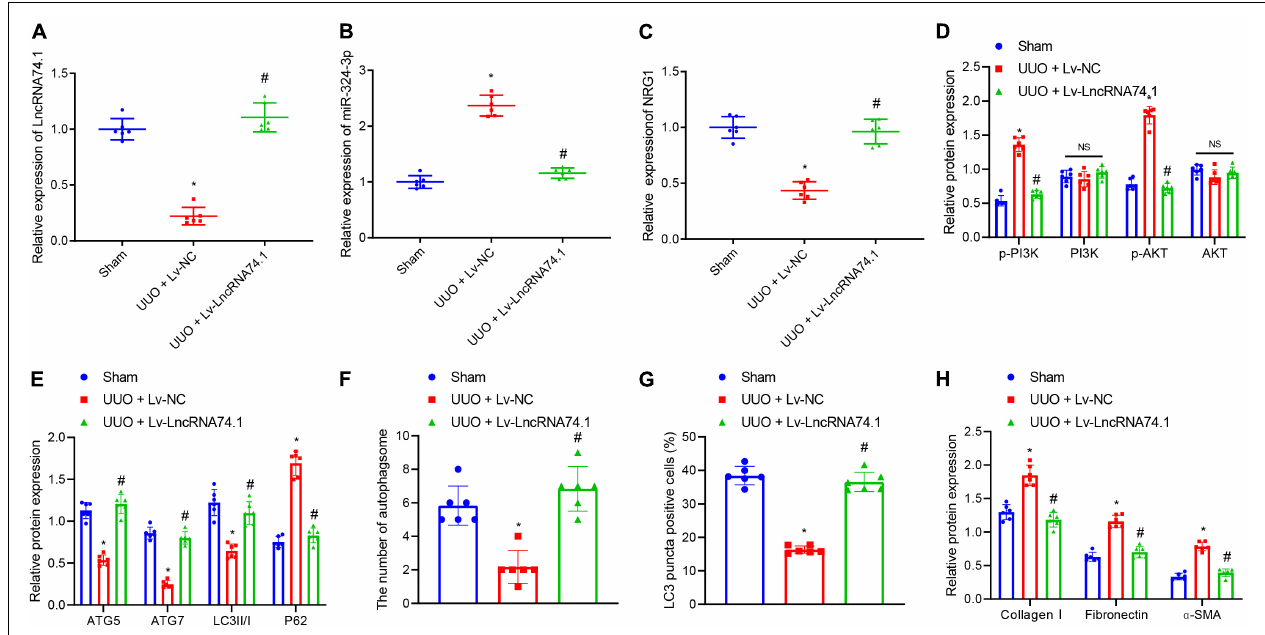
FIGURE 7 | The in vivo verification of lncRNA 74.1 inhibition of renal fibrosis by inhibition of miR-324-3p/NRG1-mediated PI3K/AKT signaling pathway. (A) lncRNA 74.1 expression in mouse renal tissues determined using RT-qPCR; (B) miR-324-3p expression in mouse renal tissues determined using RT-qPCR; (C) NRG1 expression in mouse renal tissues determined using RT-qPCR; (D) protein expressions of PI3K, p-PI3K, AKT, and p-AKT in mouse renal tissues by Western blot; (E) protein expressions of ATG5, ATG7, and LC3II/I in mouse renal tissues by Western blot; (F) TEM observation of autophagosomes in mouse renal tissues with different treatments; (G) proportion of LC3 positive cells in mouse renal tissues with different treatments by immunofluorescence assay; (H) protein level of fibrosis markers in in mouse renal tissues by Western blot. * p < 0.05 as compared with the sham group; # p < 0.05 as compared with the UUO + Lv-NC group. The measurement data were expressed as mean ± standard deviation. One-way ANOVA was used for data comparisons among multiple groups, followed by Tukey’s post hoc test. n =